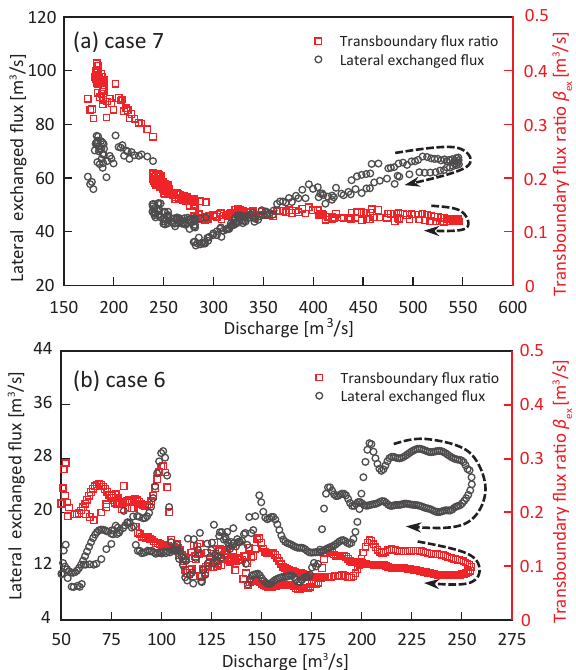
Figure 9. The transboundary flux ratio (or the absolute transbound- ary flux) versus river discharge of the (a) 50 year flood (case no. 7) and (b) 10 year flood (case no. 6).